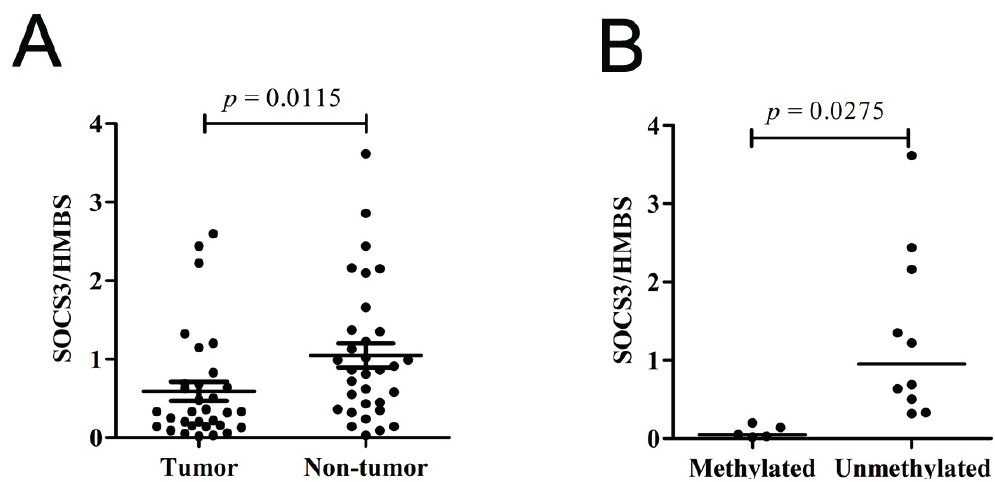
Figure 4. SOCS3 mRNA expression levels in tumor and non-tumor tissues. ( A ) SOCS3 mRNA expression level in 32 pairs of HCC tumor and non-tumor tissues; and ( B ) SOCS3 expression level in hypermethylated HCC tissues (intensity ≥ 40%) and unmethylated tissues (intensity <